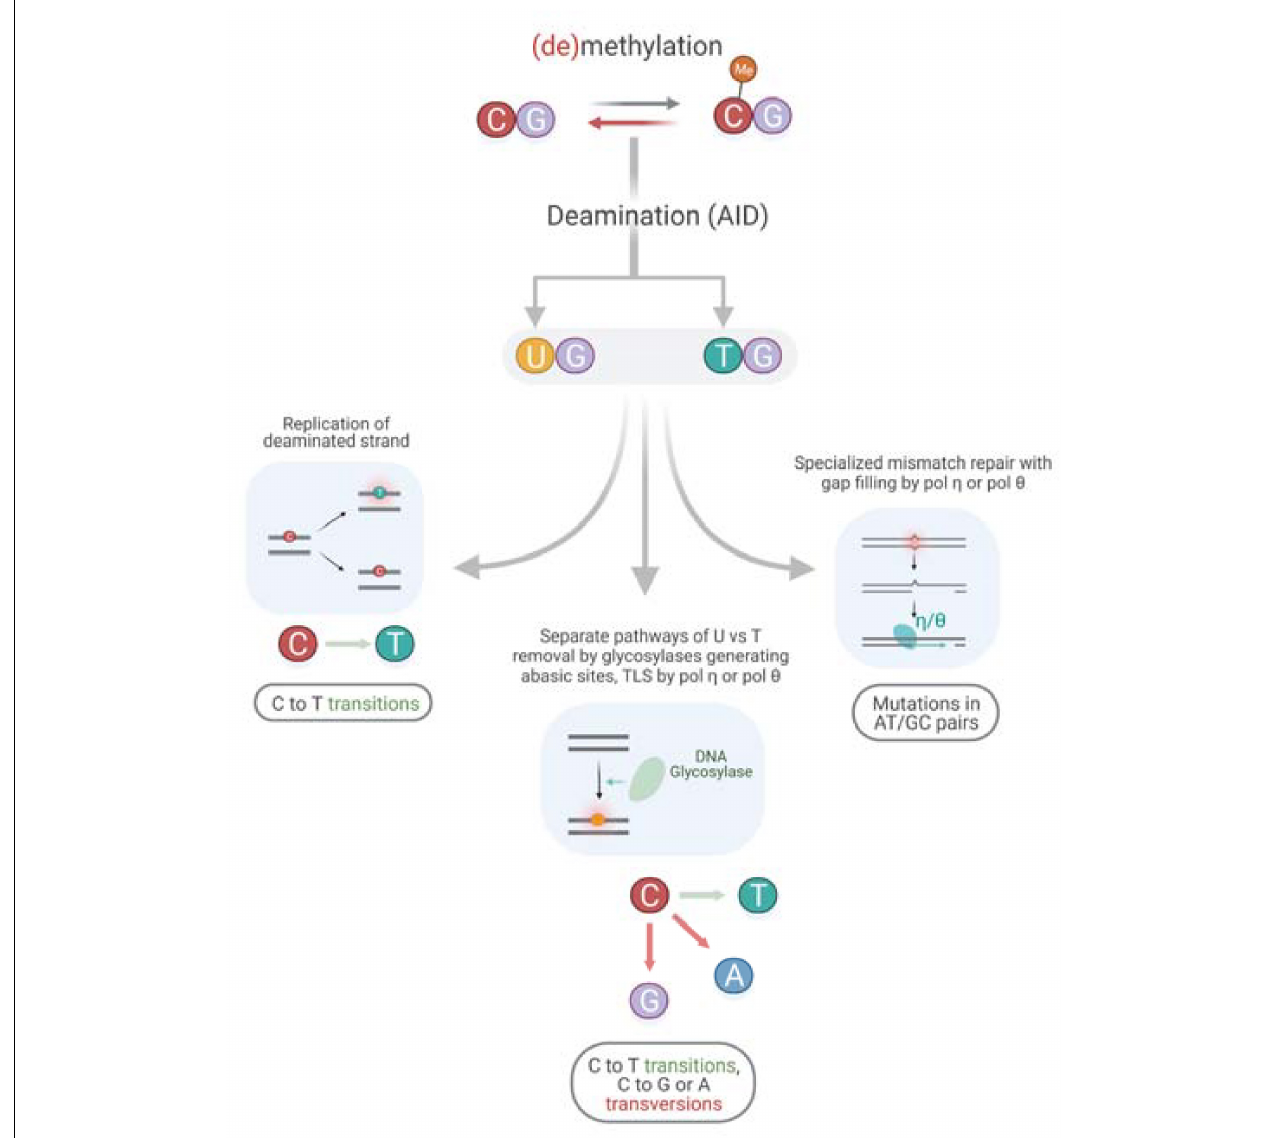
FIGURE 4 | Putative mechanism of an interplay between AID and TLS polymerases.